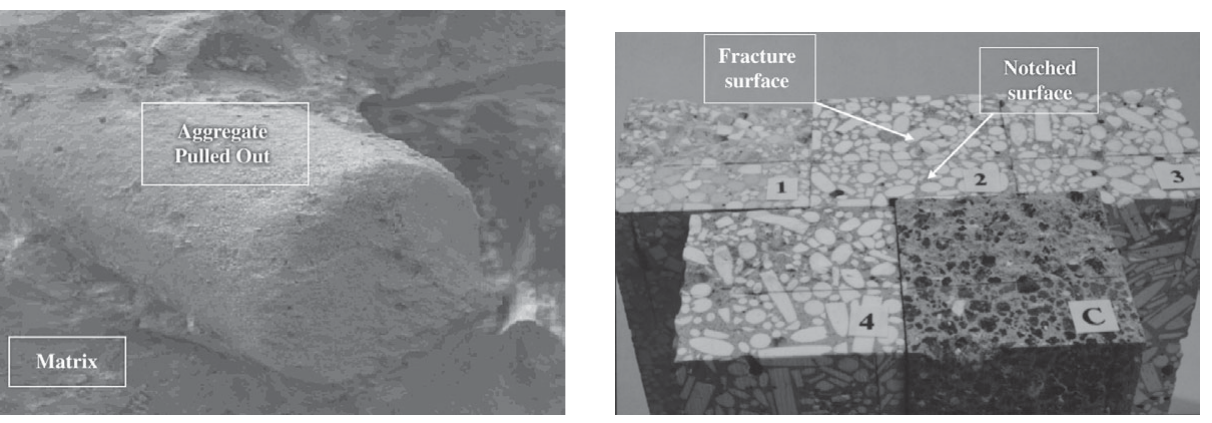
Figure 6. SEM Micrograph of an unfired specimen – Aspect ratio 3. Aggregate protruding from the fracture surface. (30×)